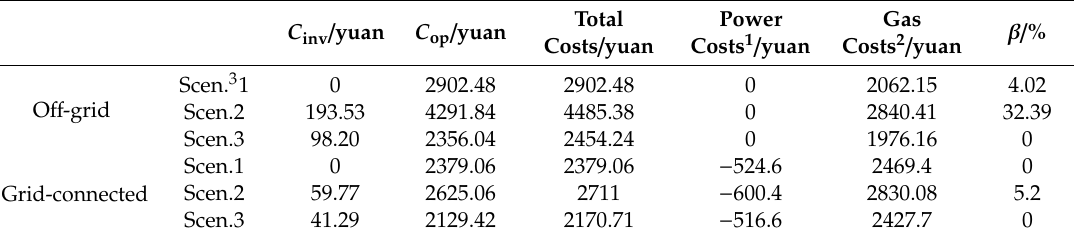
Table 5. The costs of the RIES in di ff erent